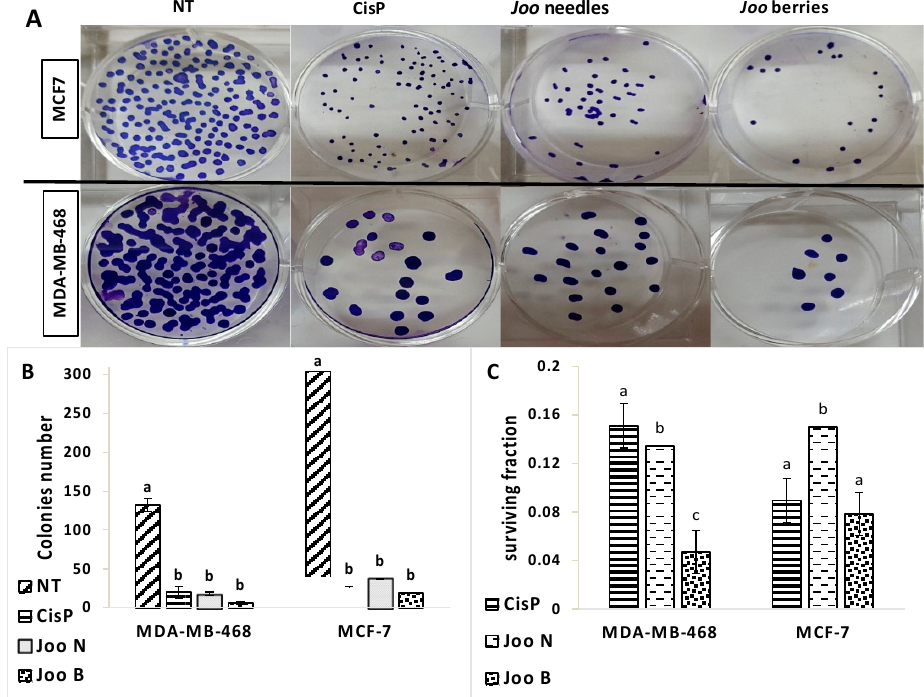
Figure 1. Clonogenic assay performed on MDA-MB-468 and MCF-7 cells treated with 1 µg/mL of Joo neeedles or berries extract or cisplatin (0.1 µg/mL) for 10 days. ( A ) Sample plate images from the clonogenic assay; ( B ) total number of colonies formed; ( C ) survival fraction. Each value represents the mean ± standard deviation of three independents measurements. Different letters in the same column indicate significant differences ( p < 0.001) within conditions according to one-way ANOVA multiple comparison range Test.